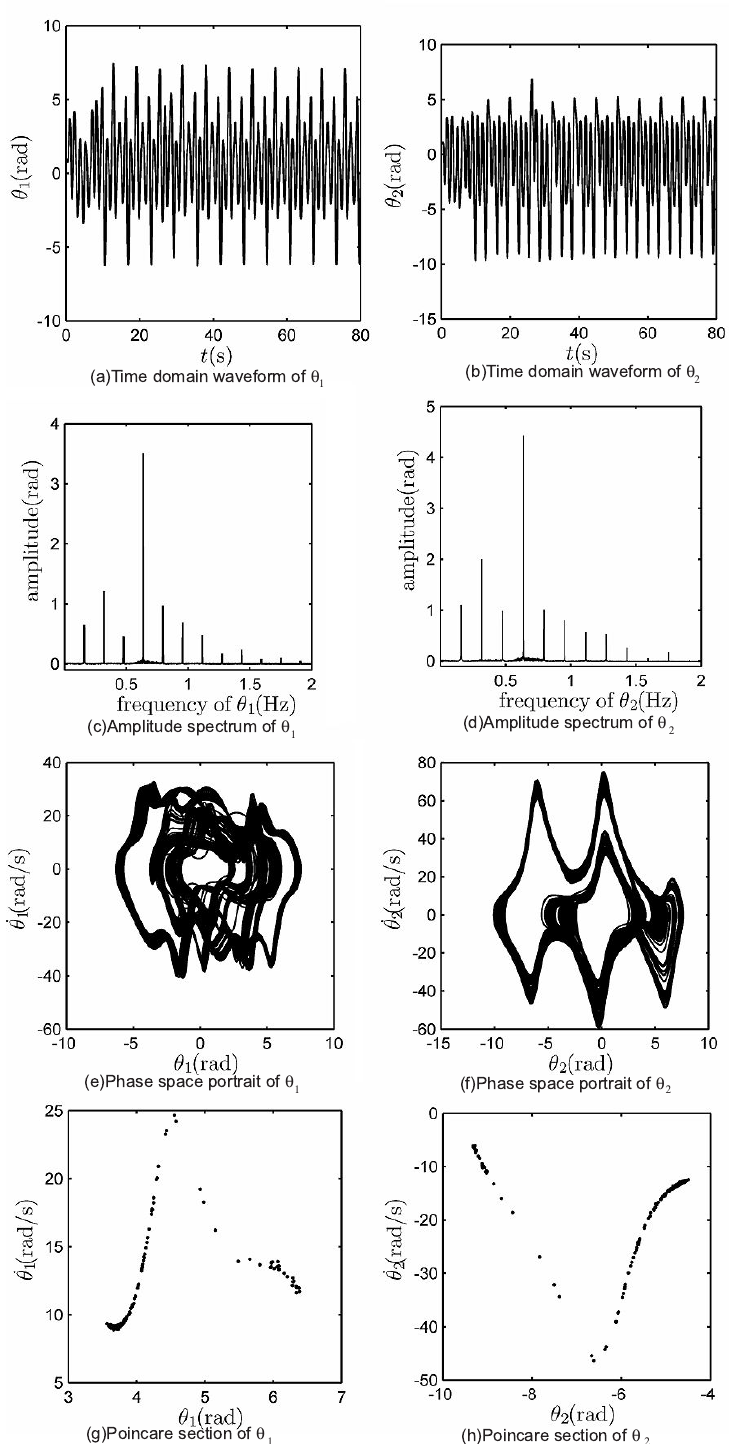
Fig. 6. The simulated chaotic motions [(a) Time domain waveform of θ 1 , (b) Time domain waveform of θ 2 , (c) Amplitude spectrum of θ 1 , (d) Amplitude spectrum of θ 2 , (e) Phase space portrait of θ 1 , (f) Phase space portrait of θ 2 , (g) Poincare section of θ 1 , (h) Poincare section of θ 2